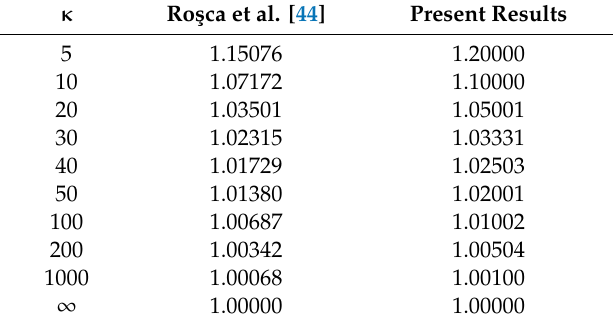
Table 2. Comparison of − C fr Re s 1/2 with di ff erent values of curvature parameter. λ = 1, M = 0, φ = 0.0, θ → ∞ r